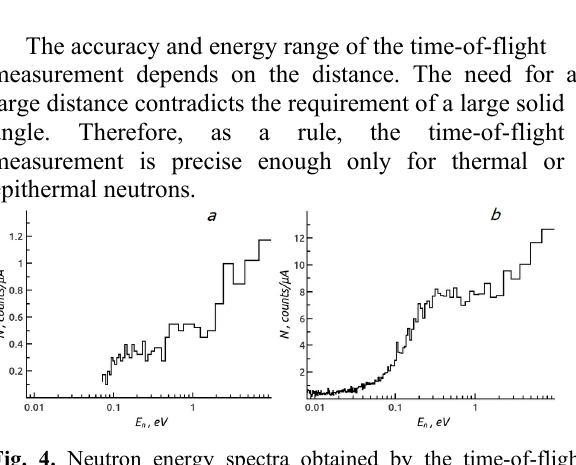
Fig. 4. Neutron energy spectra obtained by the time-of-flight technique. They were measured by: (a) 10 B-detector; (b) 3 He- tube counter .